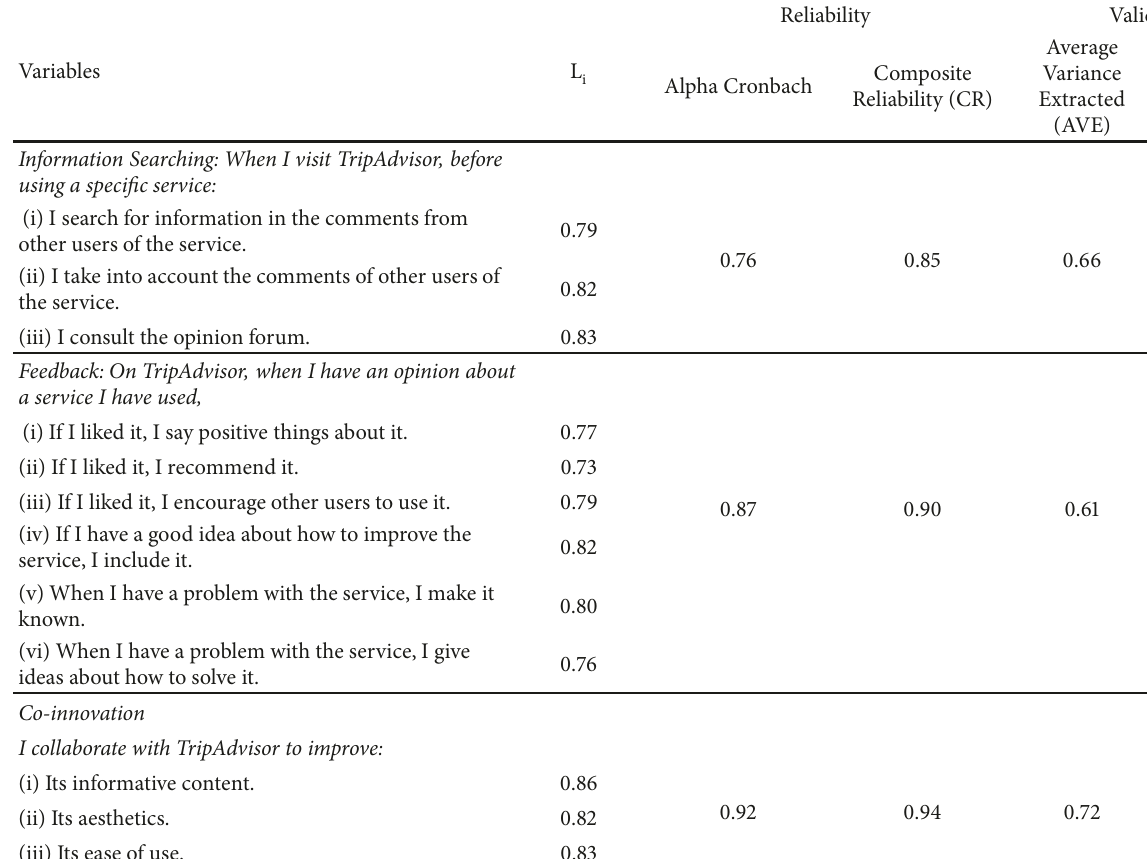
Table 2: Analysis of reliability and validity of the reflective measurement